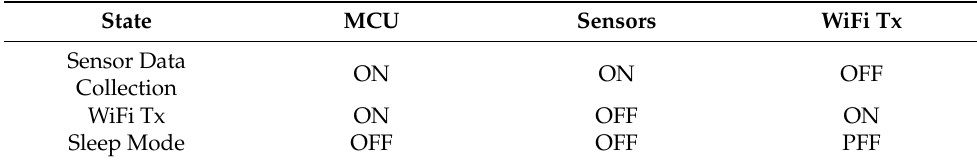
Table 2. Power state at each state.